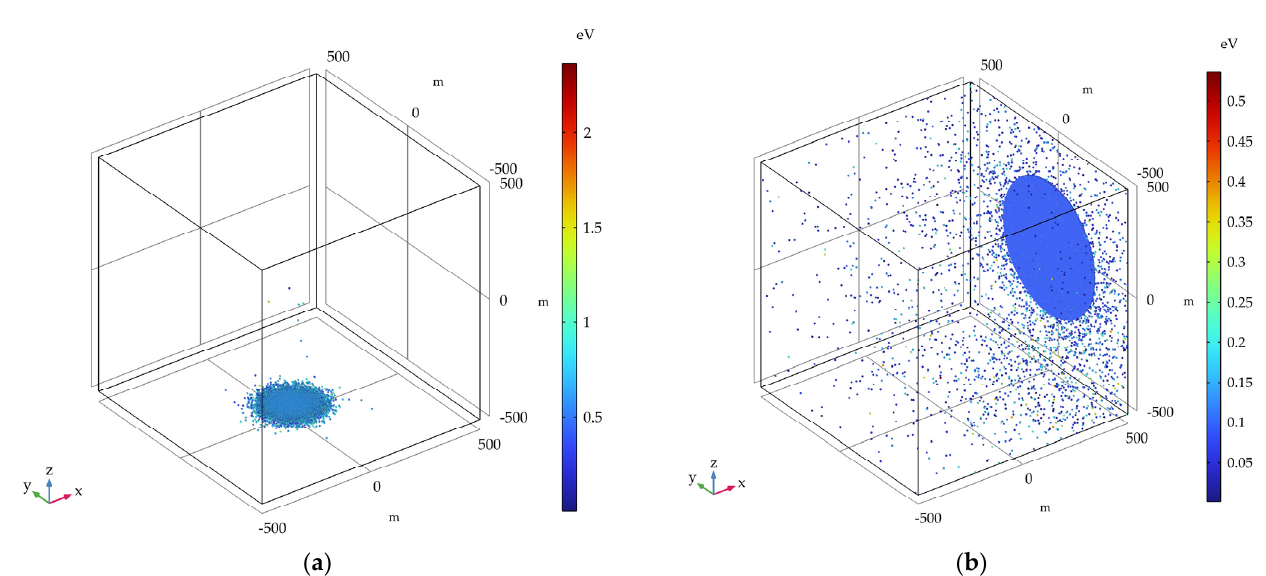
Figure 8. Simulation results of the attitude control jet in the LL case: ( a ) 120 km; ( b ) 320 km.